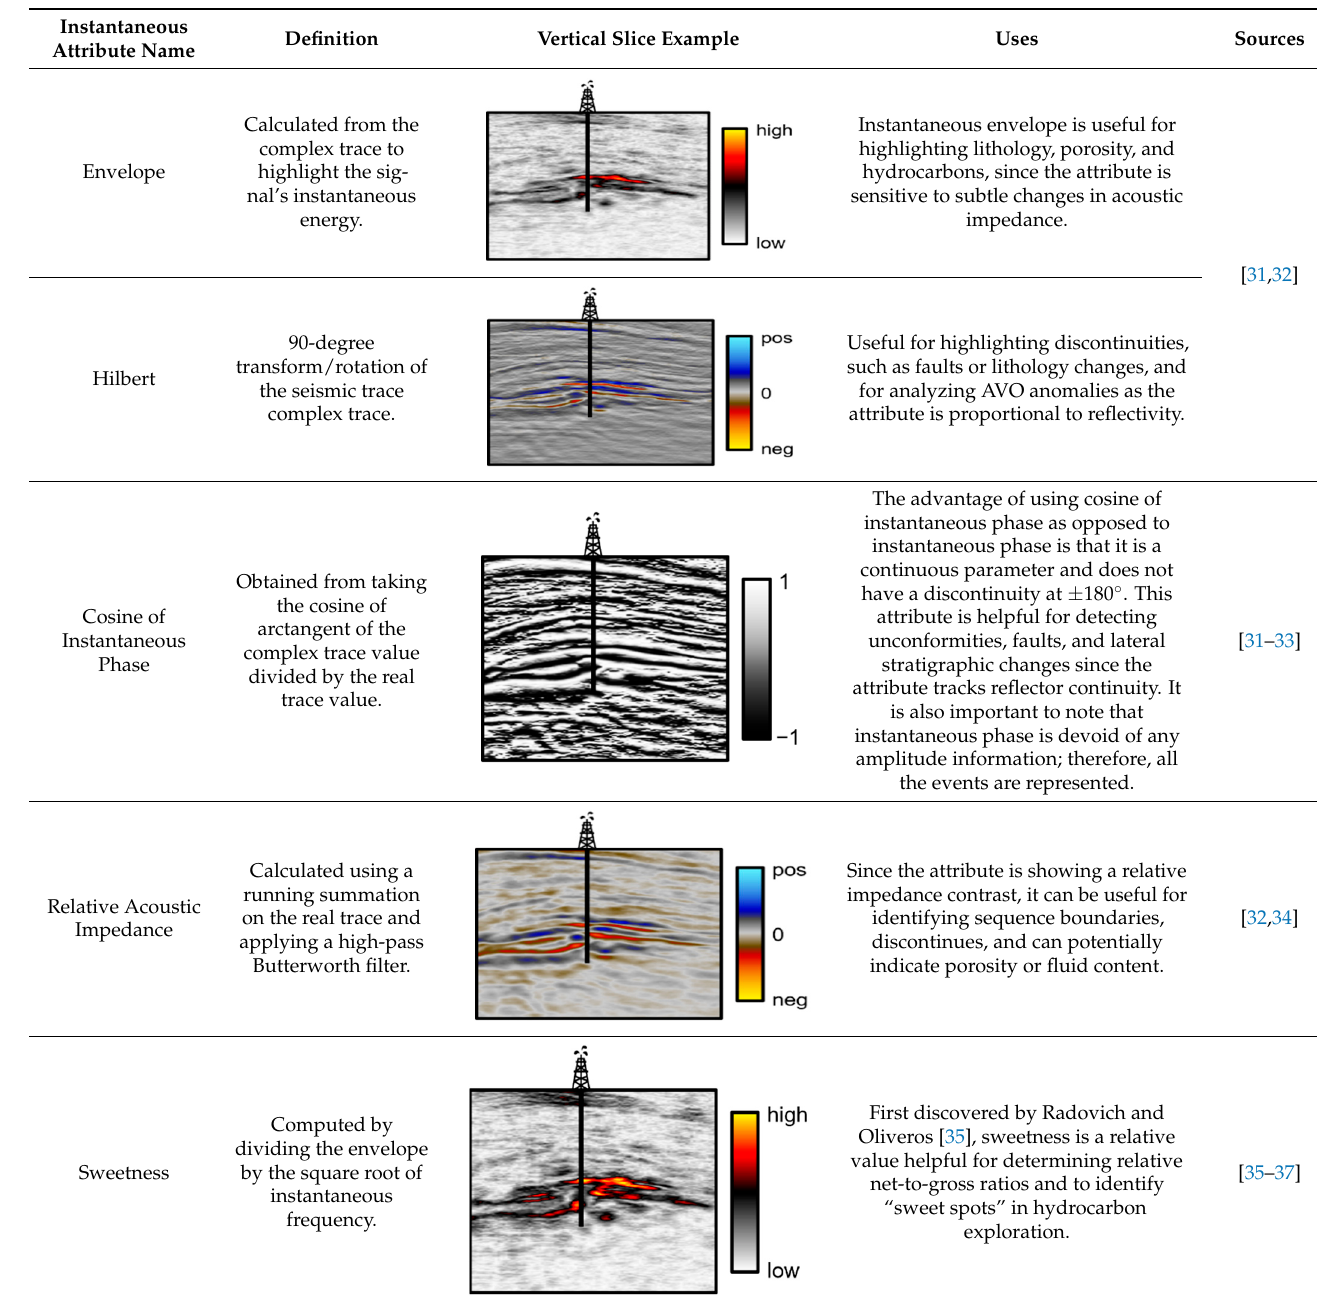
Table 1. Definitions, uses and sources for all the attributes presented within this study. The King Kong prospect from Figure 8A–F is shown under the vertical slice example.